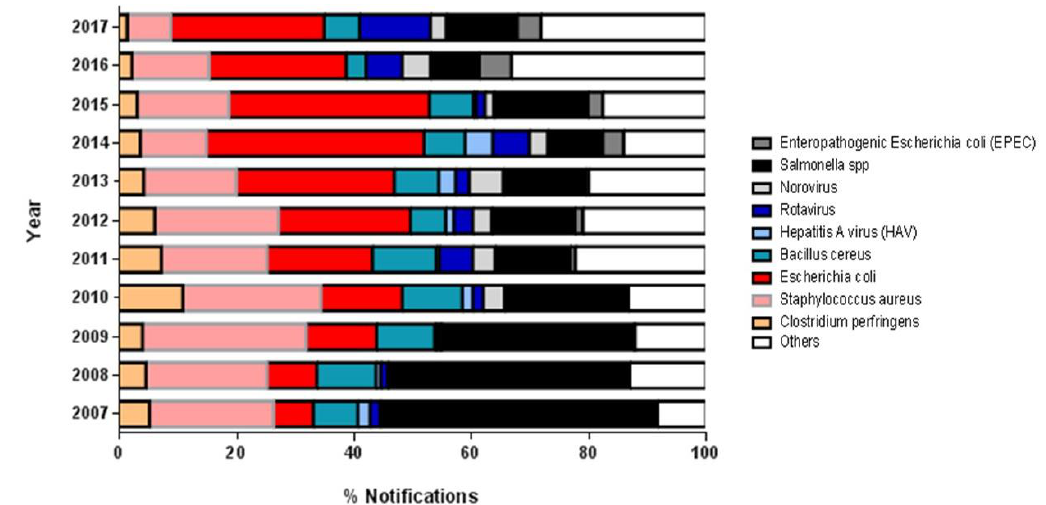
Figure 3. Percentage of notifications according to the etiological agent of the foodborne disease (2007 to